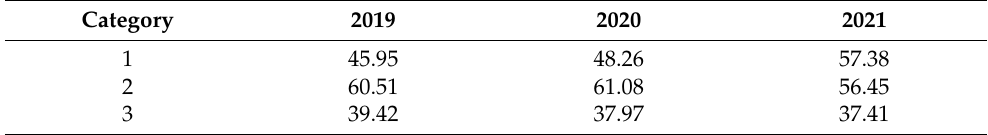
Figure 7. The number of attempted suicides per 100,000 men (2019–2021). In this case, we also observe an increase in the number of suicide attempts among men per 100,000 inhabitants in the first category, but it is not as significant as in the women’s group. We now turn to the analysis of suicides in the examined age categories, broken down by gender. The data on the group of women are as follows (Table 5 and Figure 8.)